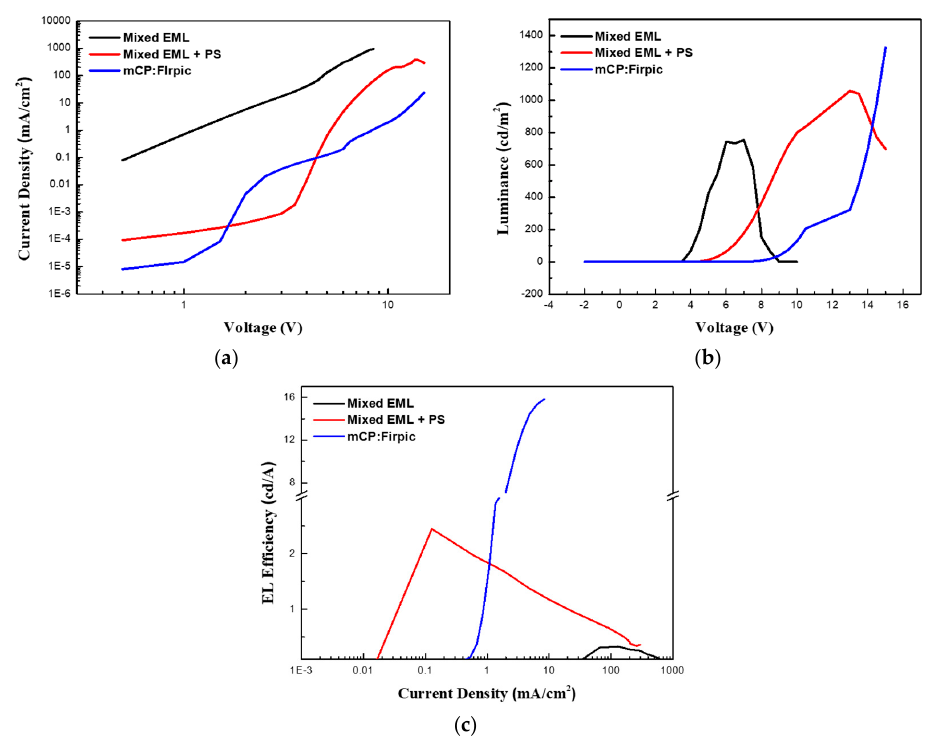
Figure 4. ( a ) Current density–voltage; ( b ) luminance–voltage; and ( c ) current efficiency–current density characteristics of monochromatic EL devices with mCP:FIrpic and hybrid EL devices with mixed EMLs and added PS.